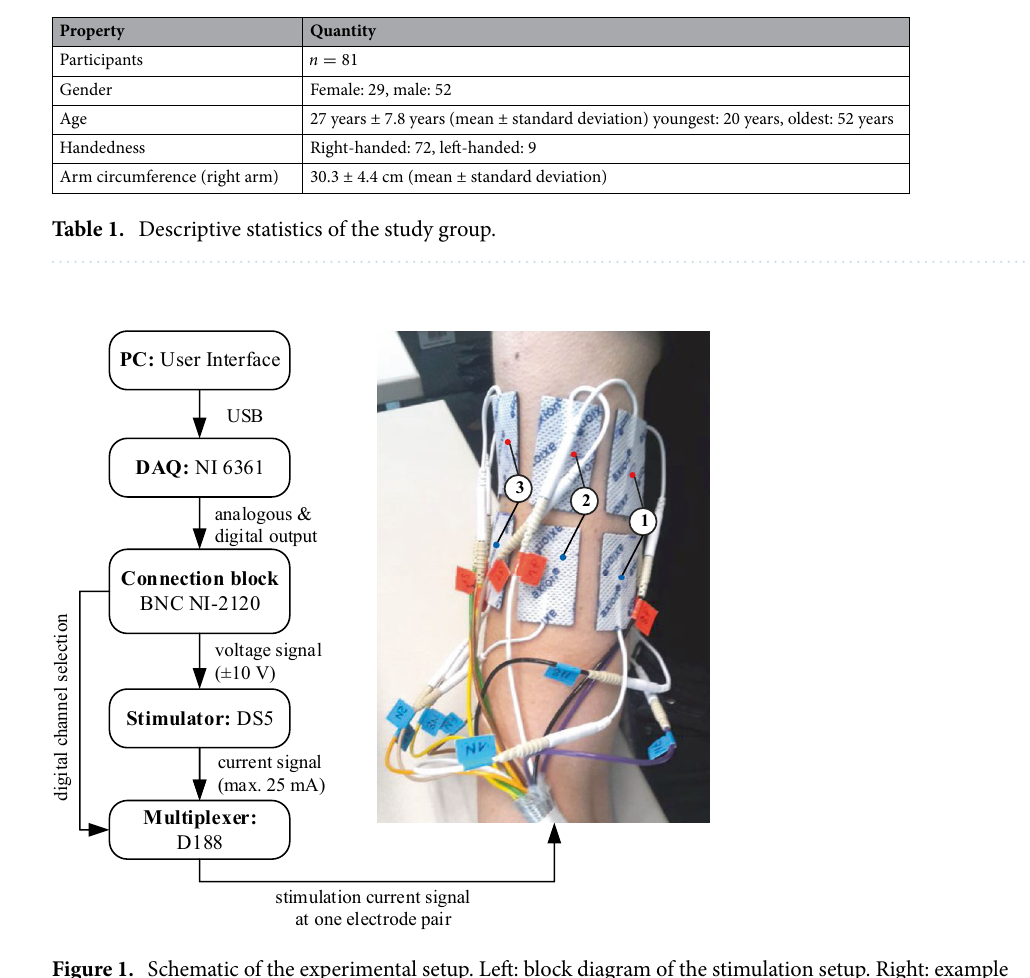
Figure 1. Schematic of the experimental setup. Left: block diagram of the stimulation setup. Right: example of electrodes at the upper arm (electrode pairs 1–3 of size 25 mm × 40 mm are visible). See text for detailed